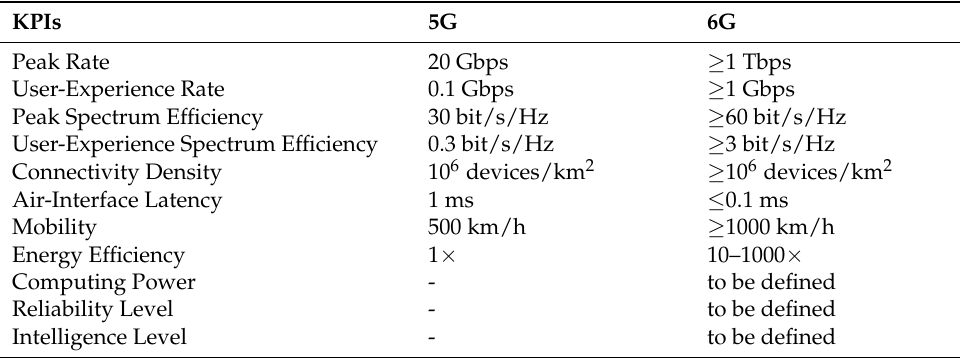
Table 1. Quantitative comparison of the KPIs between 5G and